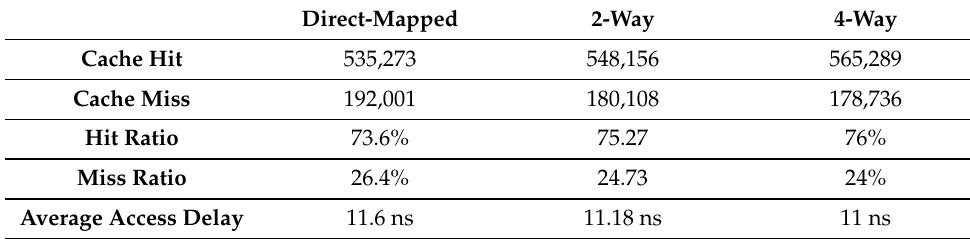
Table 6. Comparison of hit and miss rates of 50 K